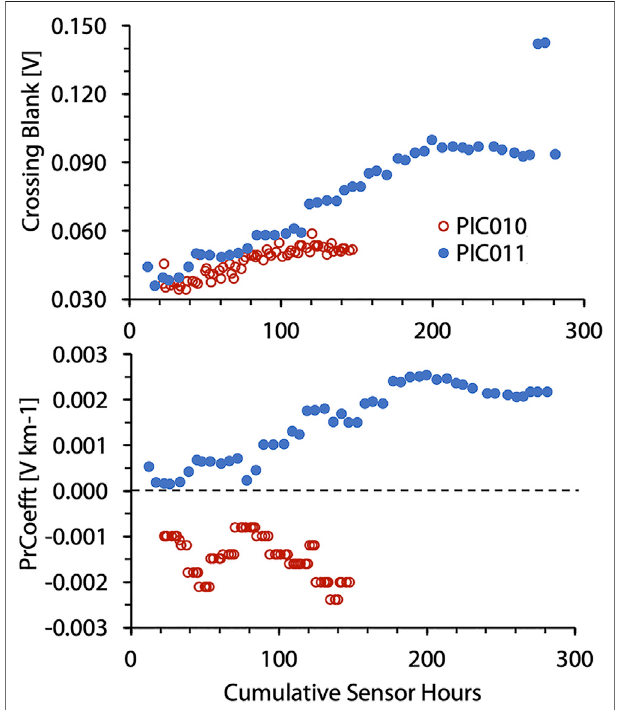
FIGURE 6 | Variation of crossing blank (V cross ) and pro fi le pressure coef fi cient (coefft press ) asafunction ofcumulativesensor hoursover the GP15 transect. PIC010 and PIC011 showed different pressure coef fi cient behavior over